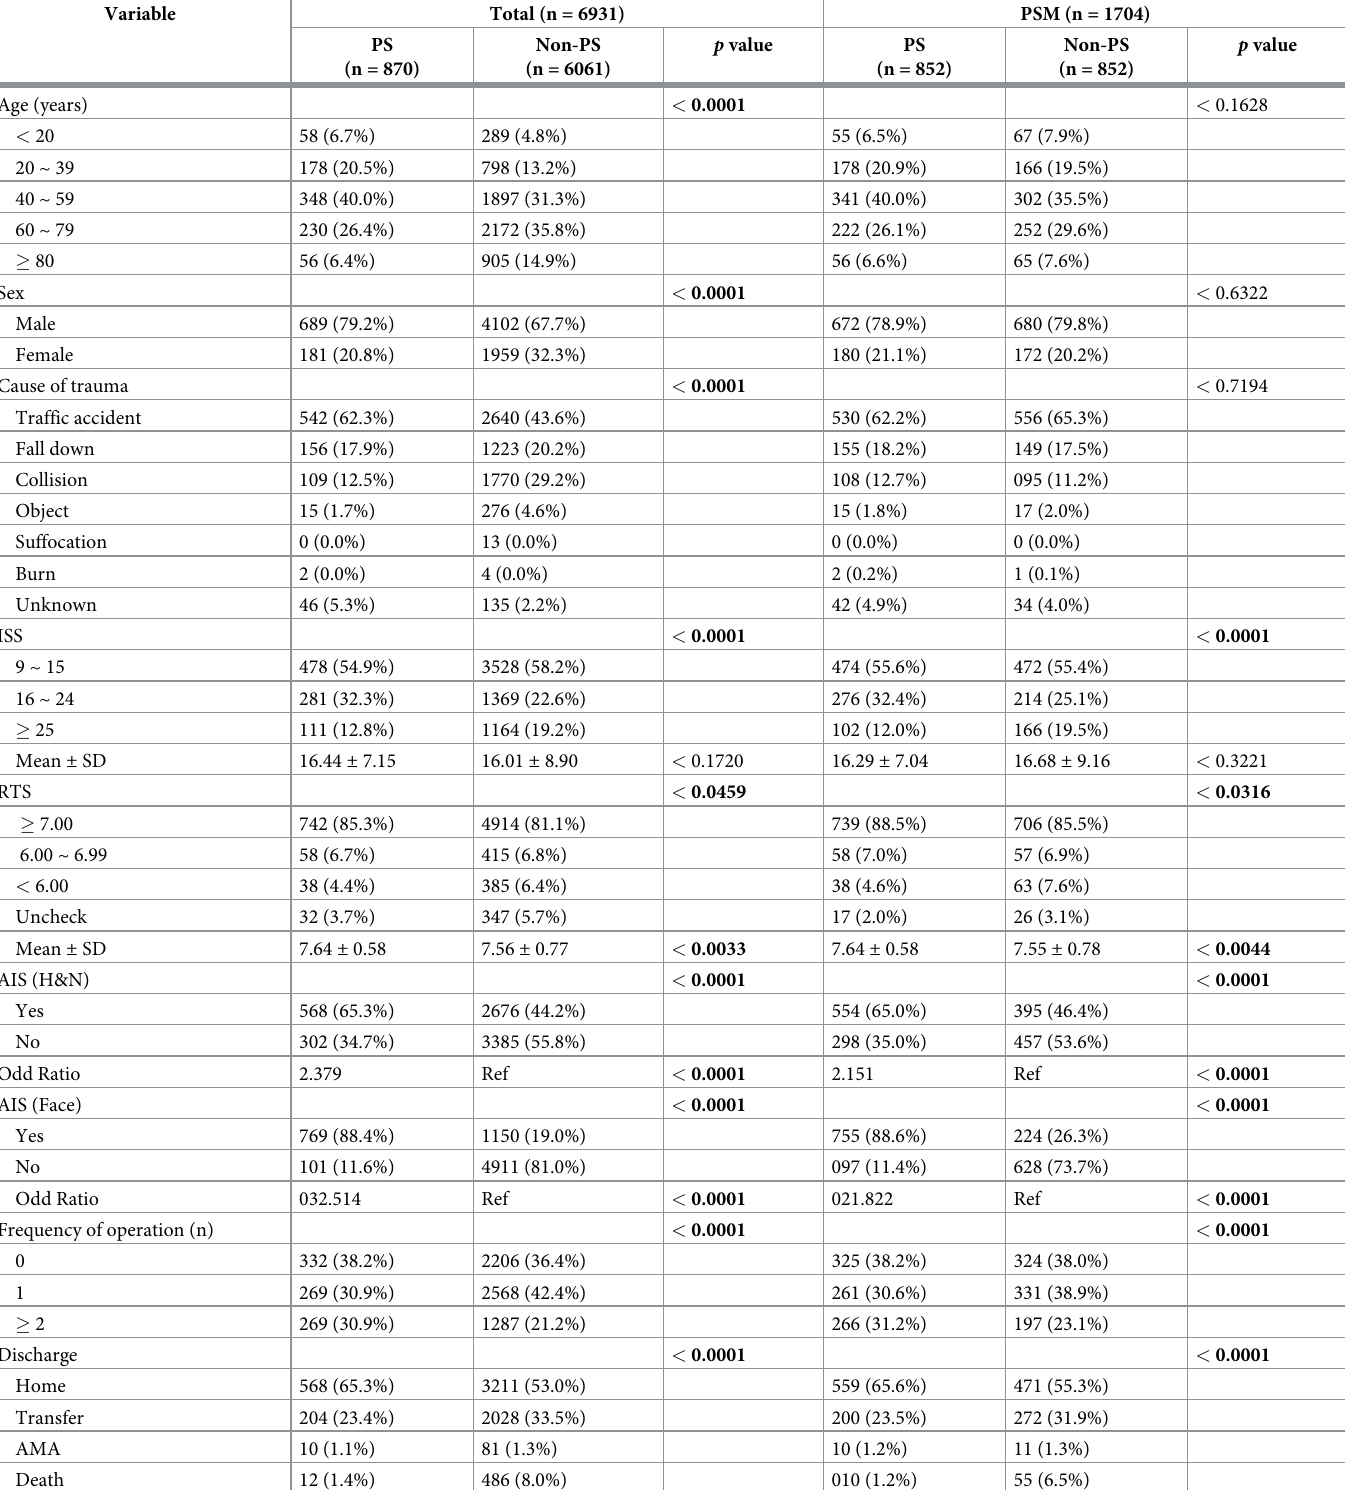
Table 1. Characteristics of trauma patients between two